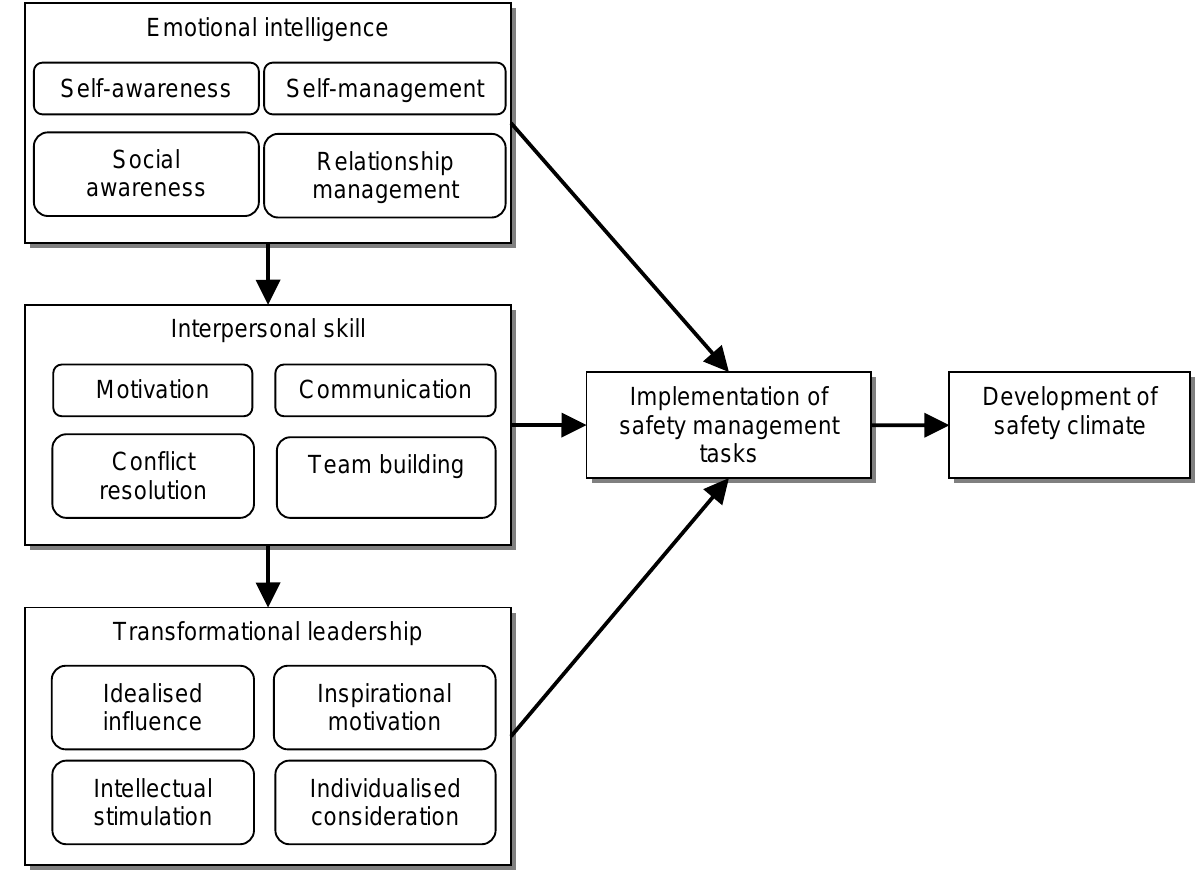
Figure 1 The theoretical model for this research